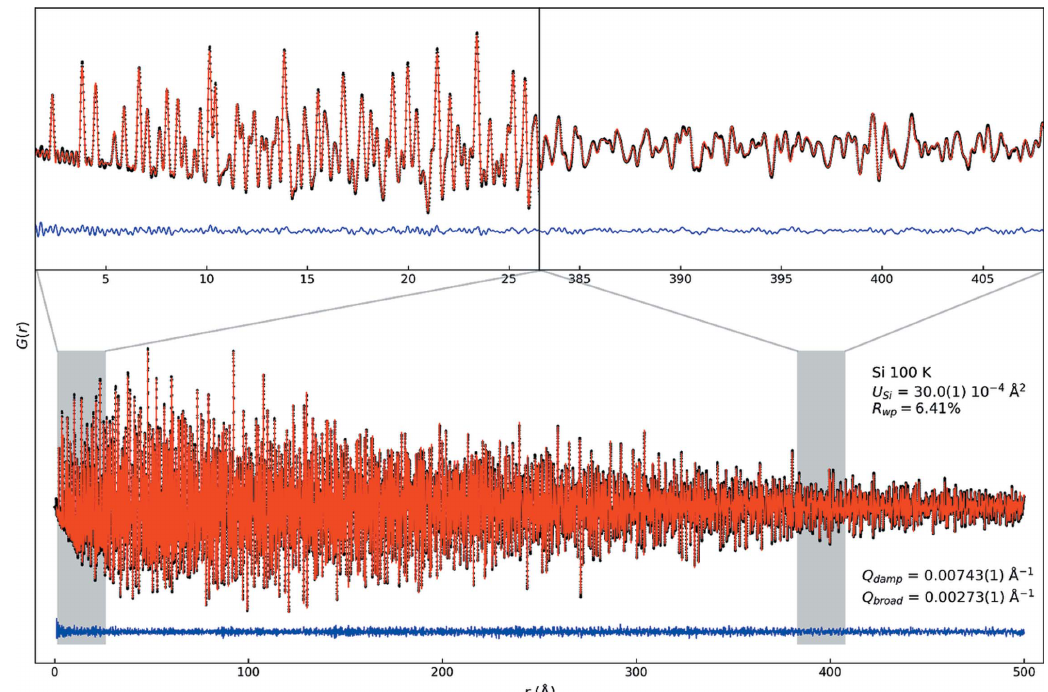
Figure 5 PDFanalysis results of the Si data at 100 K in a range up to r = 500 A˚ . Data points, the calculated model and their differences are shown by black dots, a red line and a blue line,